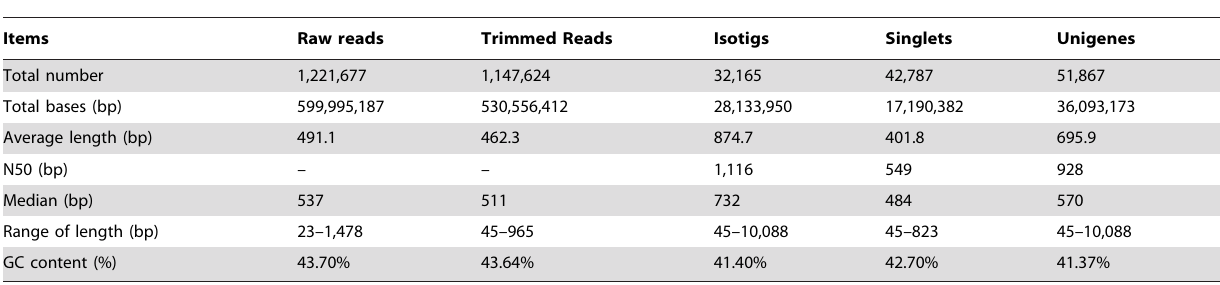
Table 1. Summary of yellow horn 454 sequencing and assembly.